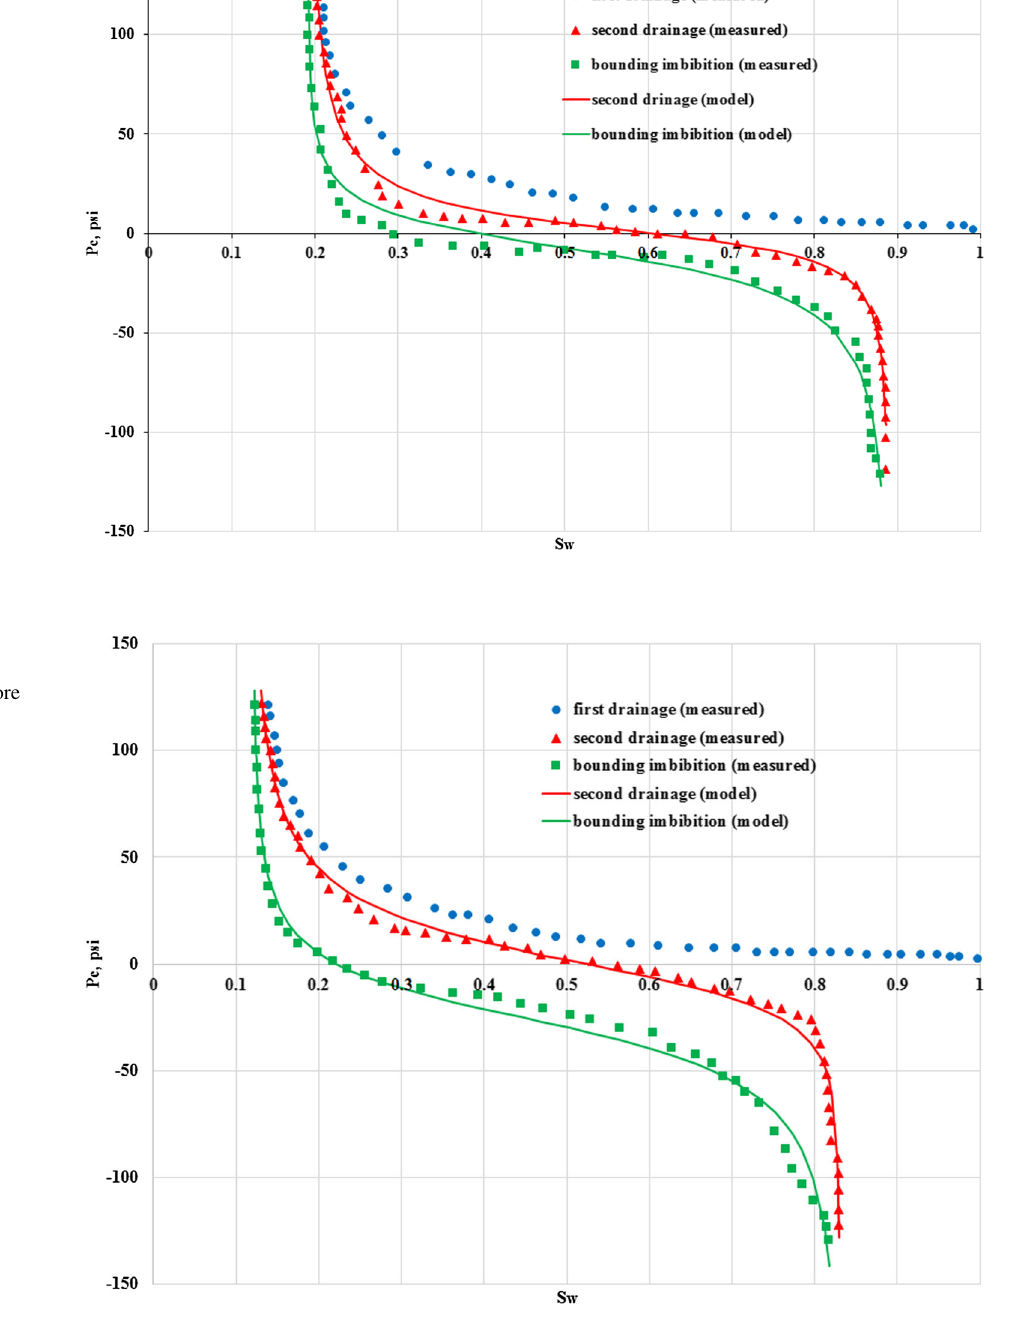
Fig. 3 Curve fitting of